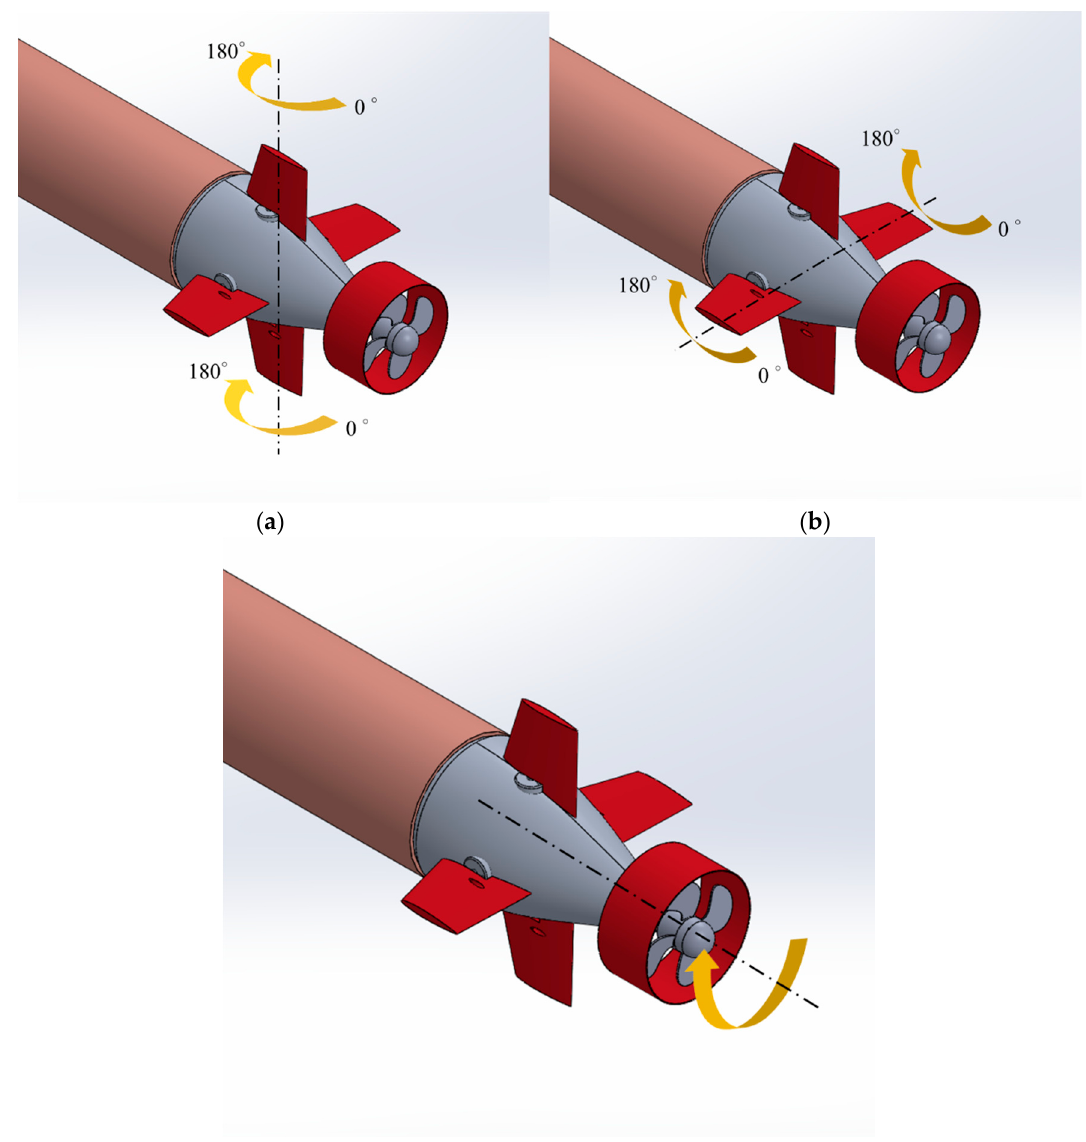
Figure 32. Schematic diagrams of rotation of ( a ) the vertical rudder plane; ( b ) the horizontal rudder plane; and ( c ) the propeller.